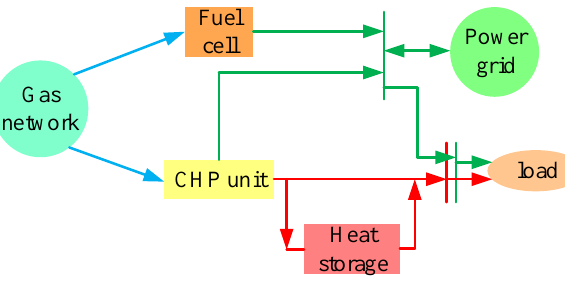
Figure 4. Principle of decoupling mode of Following the Electric Load (FEL).